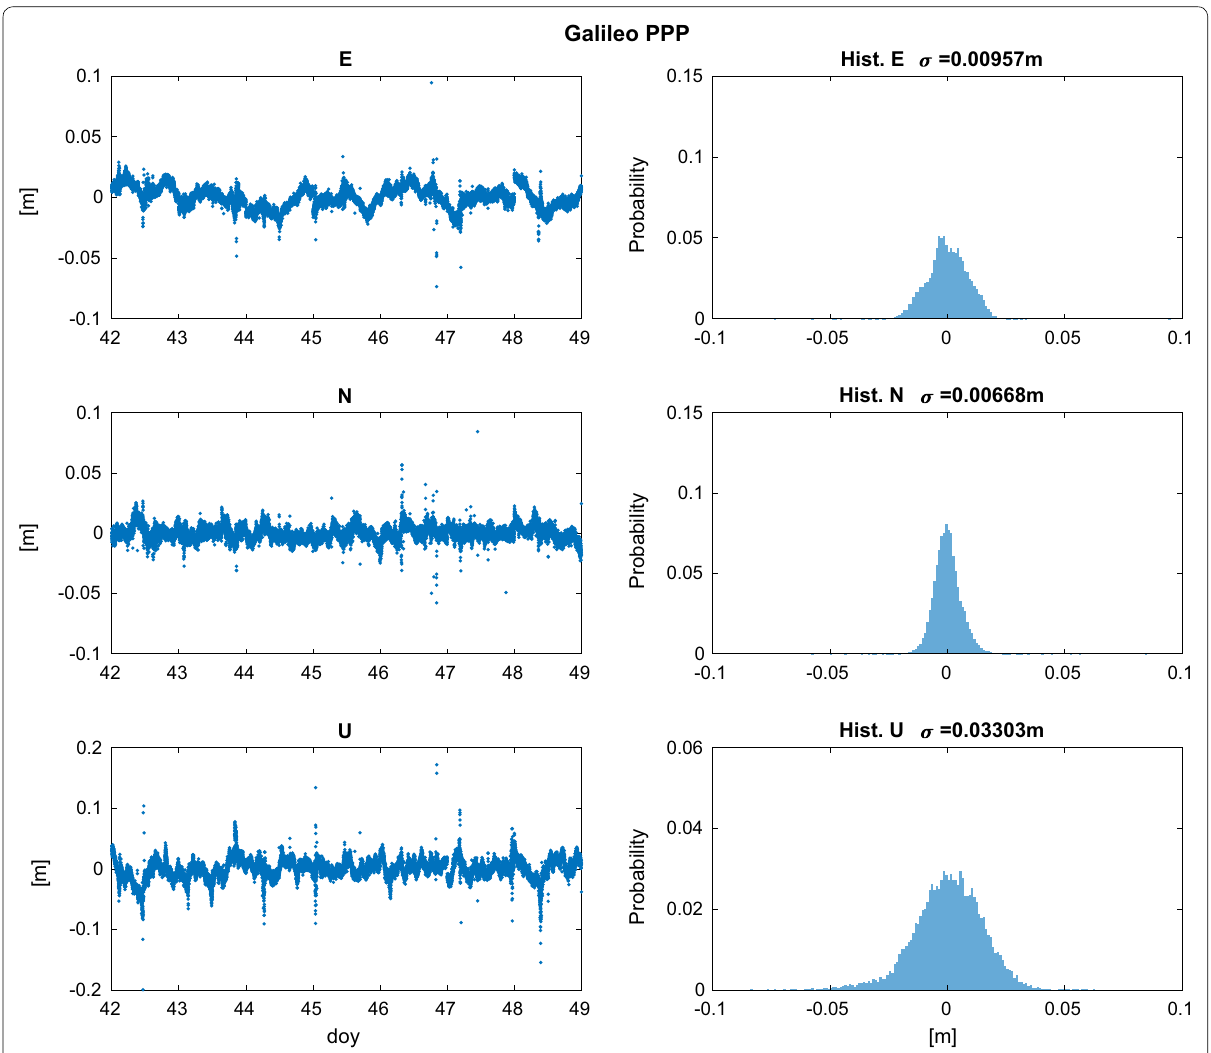
Fig. 2 Galileo-only PPP solutions of BRUX station in East (E), North (N) and Up (U) components (left) and their respective histograms with 1 σ values